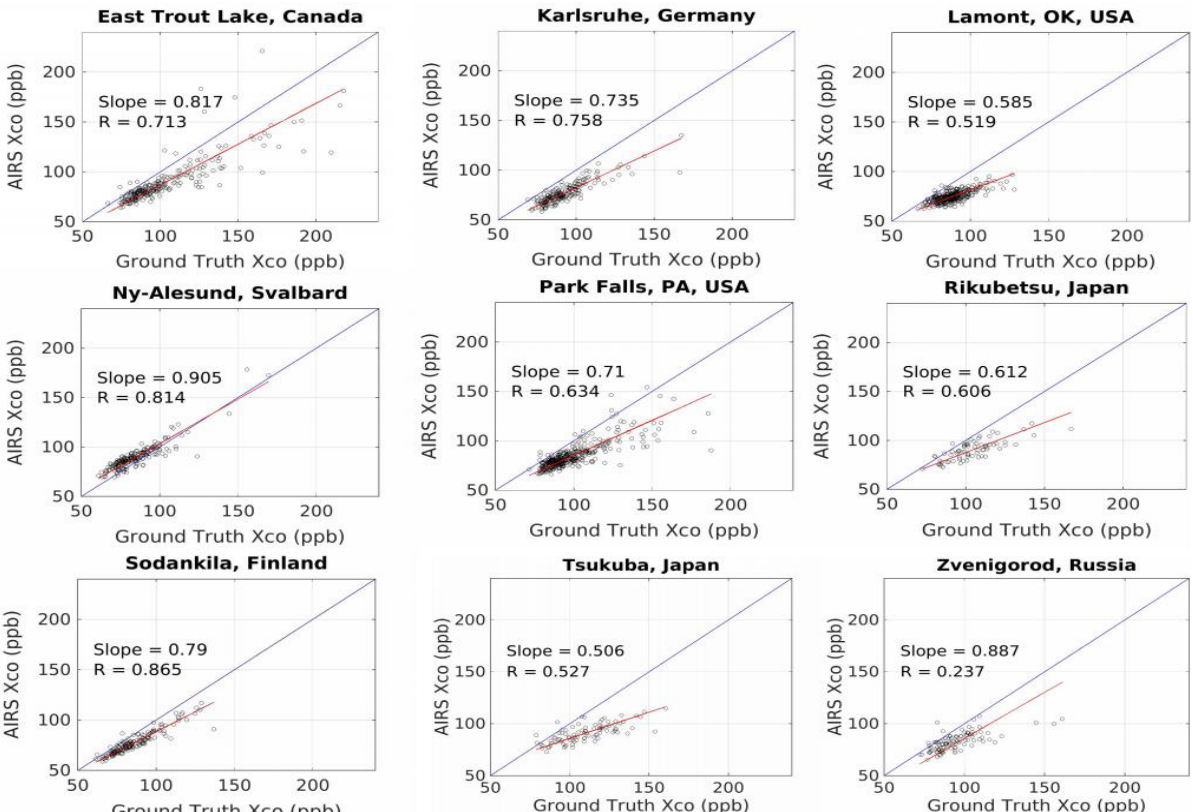
Figure 1. Daily mean Xco measured by AIRS compared with ground-based network.